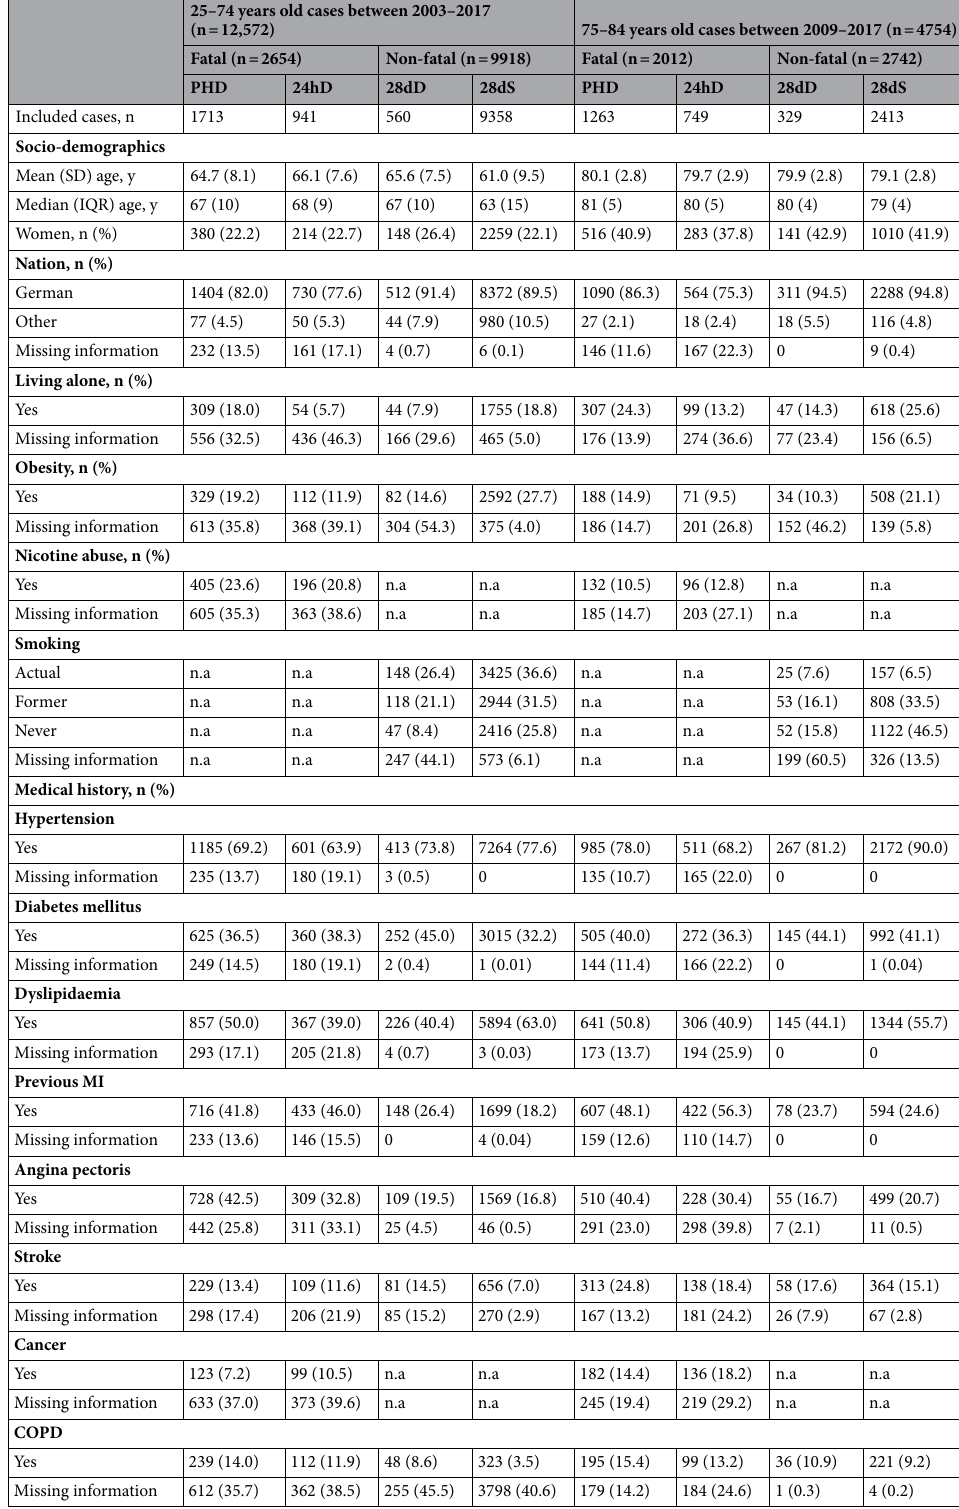
Table 1. Characteristics of the study population (n = 17,326) by age-group and the epidemiologic MONICA algorithm for the fatal coronary heart disease and non-fatal acute MI diagnosis. PHD pre-hospital deaths, 24hD death within the first 24 h after hospitalization, 28dD death within 2nd and 28th day after acute event, 28dS 28-day survivors, n.a. not available due to differences in data source and data collection regarding fatal and non-fatal cases, COPD chronic obstructive pulmonary